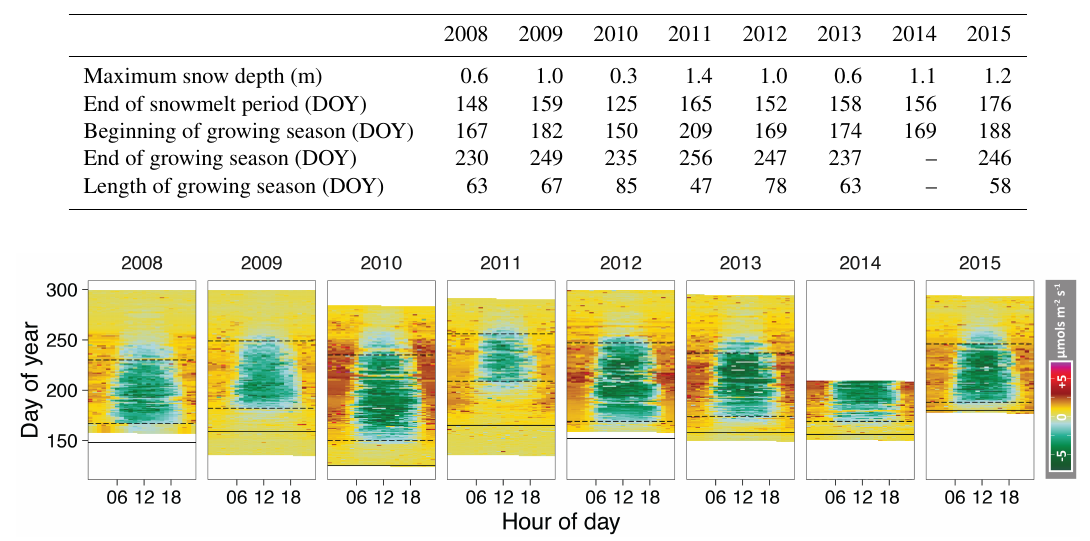
Table 1. Summary of the phenology-related variables for the period 2008–2015.